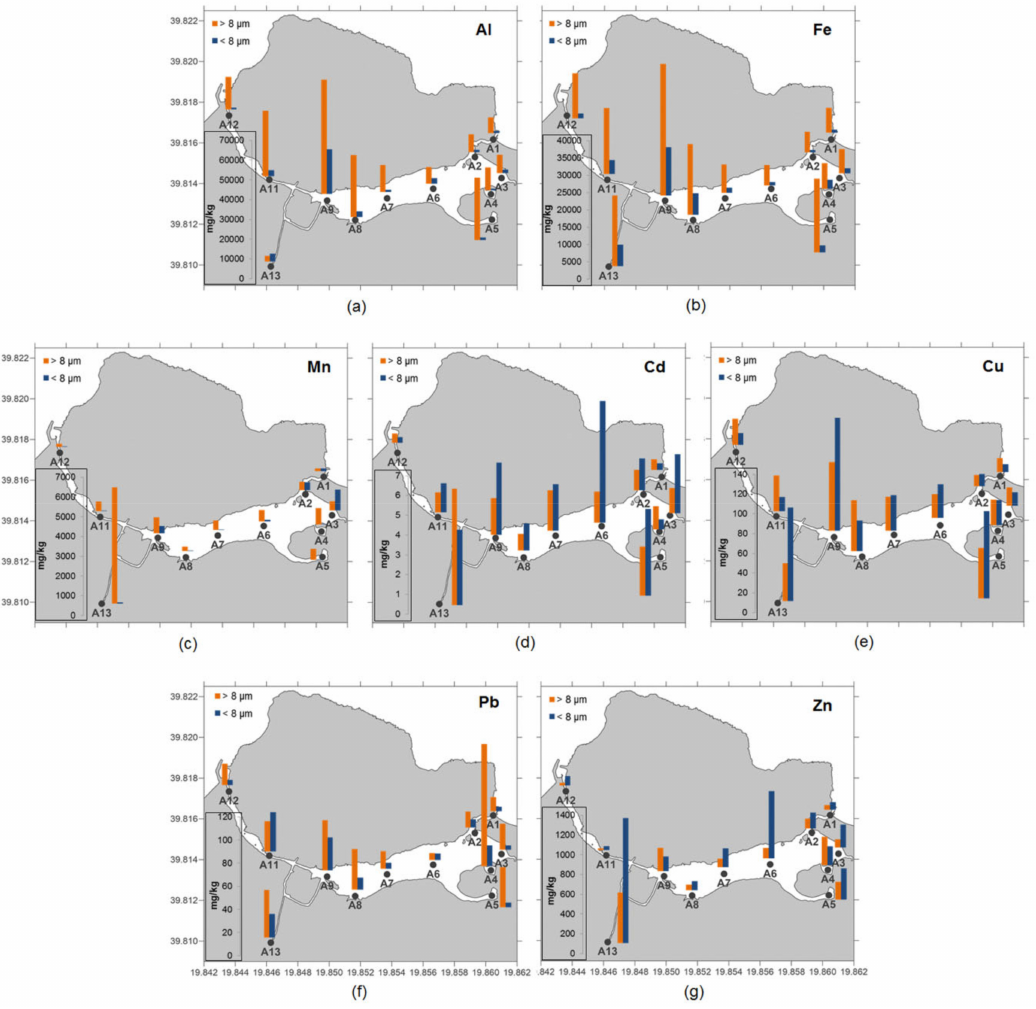
Figure 3. Spatial variation of particulate metal contents (w / w) of the > 8 µ m and the < 8 µ m fraction of SPM: ( a ) Al, ( b ) Fe, ( c ) Mn, ( d ) Cd, ( e ) Cu, ( f ) Pb, and ( g )